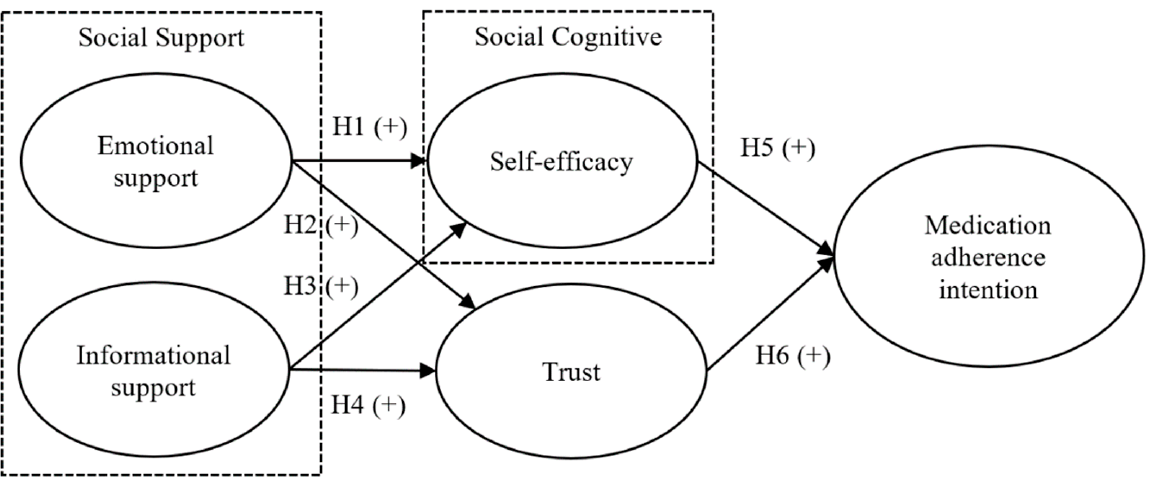
Figure 1. Research model (+ means positive direction).